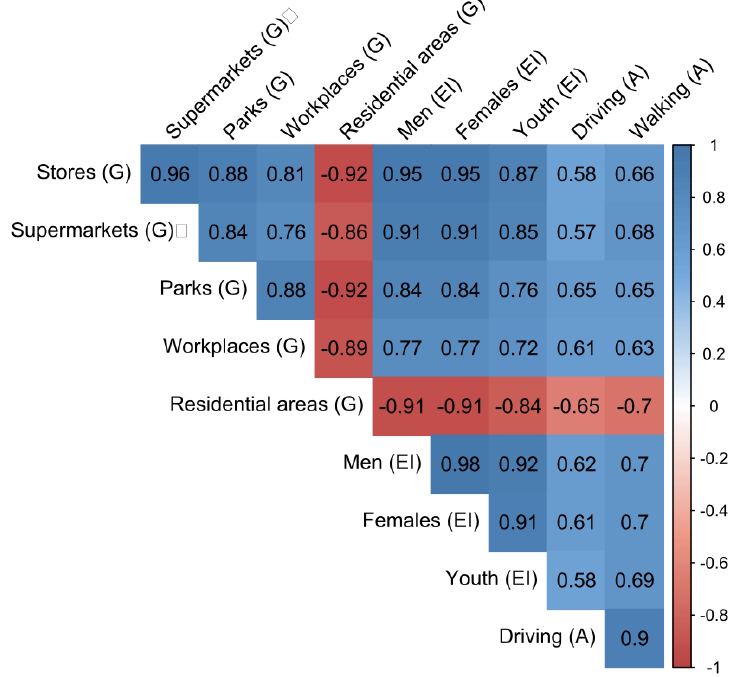
Figure 8. The linear relationship between the exposure indicator (EI) and the mobility reports provided by Google (G) and Apple (A) for 1 March 2020, and 19 May